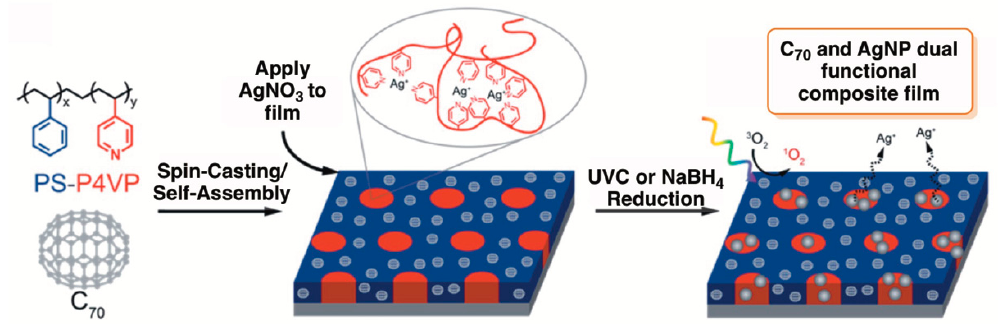
Figure 7. Schematic representation of the procedure to prepare PS-P4VP multifunctional antimicrobial films containing C 70 and in situ prepared AgNPs. Reproduced from Reference [80] with permission from the American Chemical Society.